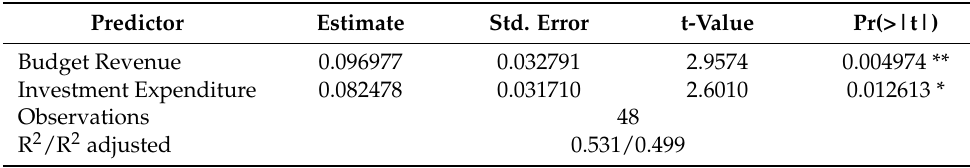
Table 10. Fixed Effects panel regression model.